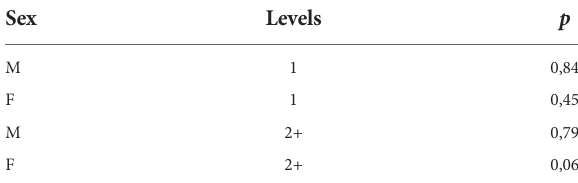
TABLE 3 Blood loss volume distributions and the possible impact of NSAID on mean and range of blood loss volume per subgroup. NSAID Levels Sex